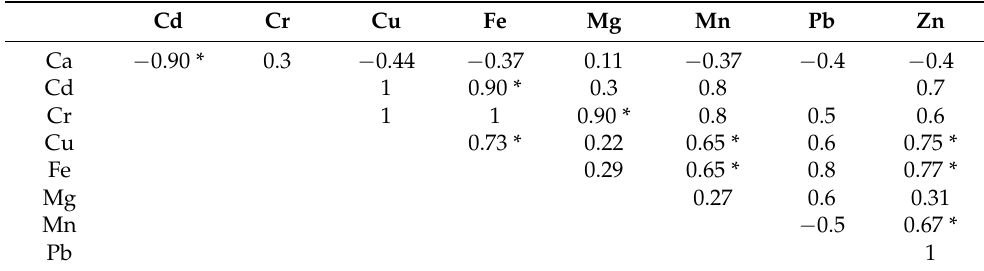
Table 5. The values of the correlation coefficients for the content of analytes in samples in advanced atherosclerosis stages. Statistically significant values are marked with an asterisk.